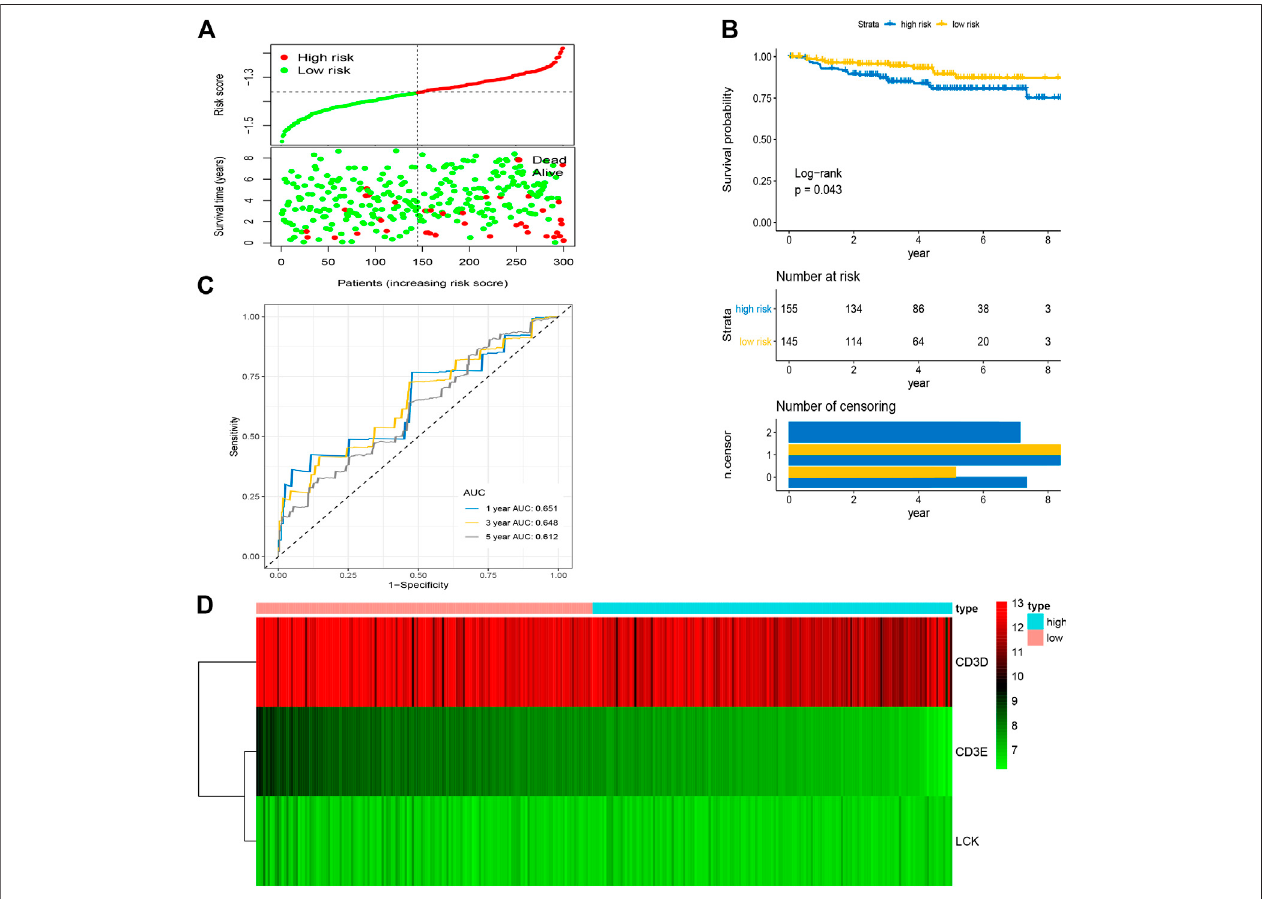
FIGURE 9 | Validation of prognostic signature based on four hub IRGs in external group. (A) The distribution of risk scores and survival status between low- and high-risk groups, and mean level of risk score was set as the cut-off value. (B) The overall survival analysis of patients in two subgroups. (C) ROC curve analysis for the prediction of1-, 3-, and 5-year OSas the de fi ning point of thefour-hubIRGs signature. (D) Heatmap offour prognostic IRGs. IRGs, immune-related genes; ROC curve, receiver operating characteristic curve; OS, overall survival.